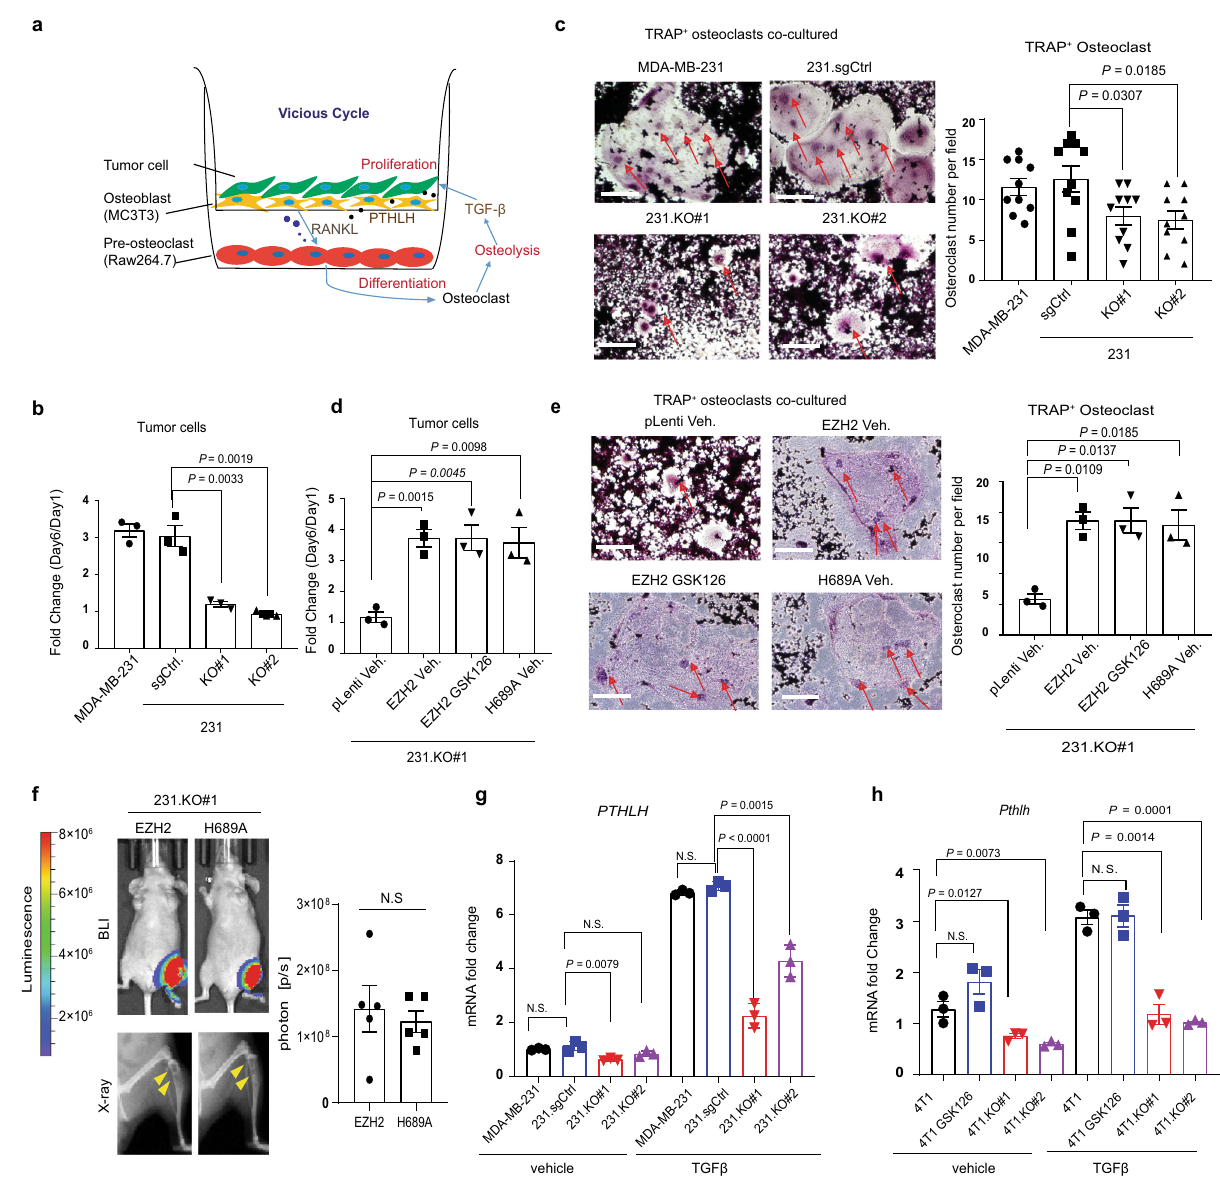
Fig. 2 EZH2 regulates the vicious cycle of breast cancer bone metastasis. a Model of triple co-culture of breast cancer cells with preosteoclasts and osetoblasts. Murine RAW 264.7 preosteoclasts were seeded into the wells of six-well plates. GFP-labeled breast cancer cells and MC3T3 osteoblasts were seeded into Millicell Hanging Cell Culture Inserts (Millipore) in the six-well plates and treated with TGF β (5 ng/mL). b Quanti fi cation of MDA-MB-231, 231.sgCtrl., 231.KO#1, and 231.KO#2 cells after co-culture with osteoclasts and MC3T3 osteoblasts treated with TGF β (5 ng/mL) for 6 days. Data are presented as means ± S.E.M. t -test (two-sided). Three biologically independent experiments. c Representative staining images and quanti fi cation of mature TRAP + osteoclasts after culture with MC3T3 osteoblasts and the indicated cancer cells, and treatment of them with TGF β (5 ng/mL) for 6 days. The arrows indicate multinuclear mature TRAP + osteoclasts. Scale bars, 200 μ m. Data are presented as means± S.E.M. t -test (two-sided). Ten random vision fi elds examined over three biologically independent experiments. d Quanti fi cation of 231.KO#1.pLenti. cells treated with vehicle, 231.KO#1.EZH2 cells treated with vehicle, 231.KO#1.EZH2 cells treated with 2 μ M GSK126, 231.KO#1.H689A cells treated with vehicle, after co-culture with osteoclasts and MC3T3 osteoblasts treated with TGF β (5 ng/mL) for 6 days. Data are presented as means ± S.E.M. t -test (two-sided). Three biologically independent experiments. e Representative staining images and quanti fi cation of mature TRAP + osteoclasts after co-culture with MC3T3 osteoblasts and the indicated cancer cells and treatment of them with TGF β (5 ng/mL) for 6 days. The arrows indicate multinuclear mature TRAP + osteoclasts. Scale bars, 200 μ m. Data are presented as means± S.E.M. t -test, (two-sided). Three biologically independent experiments. f Representative bioluminescence image (BLI), X-ray images and quanti fi cation of BLI signals of bone-metastatic lesions in the two subgroups of mice ( n = 5 in each group) intratibially injected with 231.KO#1.EZH2 or 231.KO#1.H689A cells 5 weeks post-injection. Data are presented as means ± S.E.M. t -test (two-sided). The arrows indicate osteolytic bone lesions in X-ray images. g qRT-PCR analysis of PTHLH mRNA expression in the indicated cells treated with a vehicle or TGF β (5 ng/mL, 2 h). Data are presented as means ± S.E.M. t -test (two-sided). N.S. not signi fi cant. Three biologically independent experiments. h qRT-PCR analysis of Pthlh mRNA expression in the indicated cells treated with a vehicle or TGF β (5 ng/mL, 2 h). Data are presented as means± S.E.M. t -test (two-sided). Three biologically independent experiments. All P values are indicated in the fi gures. The TGF β used in all experiments in this study is TGF β 1.